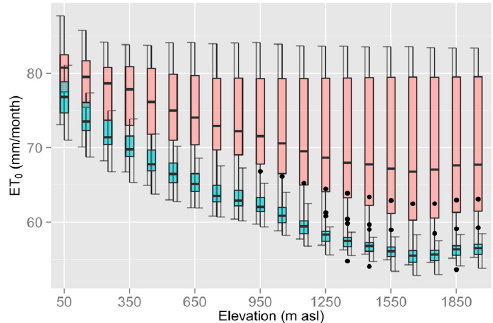
Figure 6. Elevational changes in annual average monthly reference crop ET ( ET 0 ) in mm/month. Red and blue box plots represent OBS and EXT, respectively.